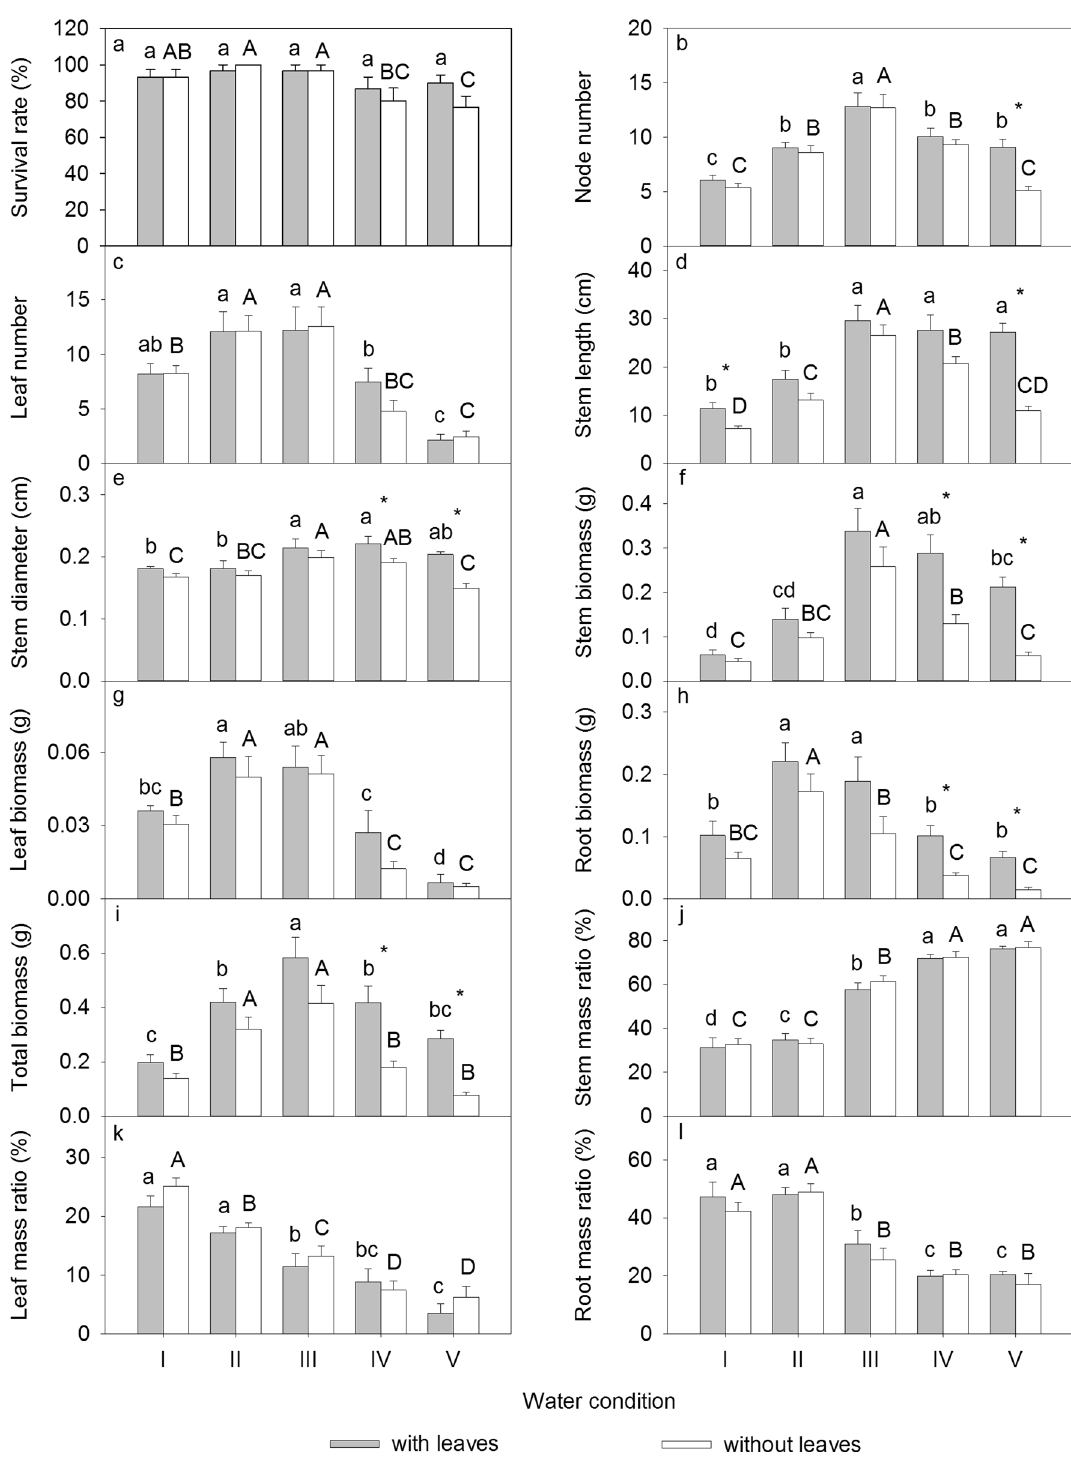
Figure 2. Survival rate, morphological traits, biomass, and biomass allocation of A. philoxeroides in Exp. 2. Means + SE are given. I, 30% soil water content; II, 70% soil water content; III, 97% soil water content; IV, water depth of 5 cm; V, water depth of 10 cm. Different uppercase and lowercase letters indicate significant differences among different water conditions. *indicates significant differences between different leaf